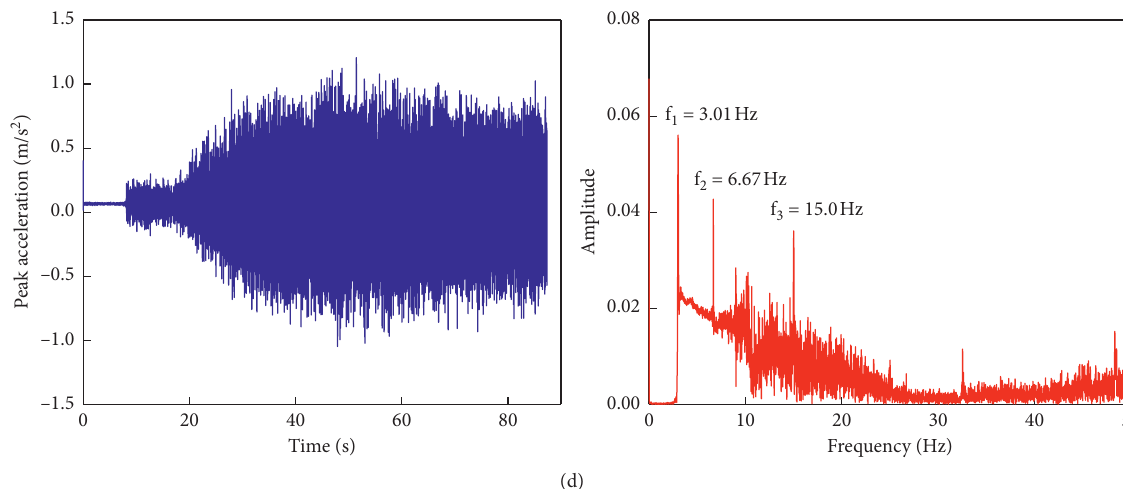
Figure 7: Acceleration time domain and frequency spectrum curves at different positions when sine wave of 0.1g is inputted in X direction.